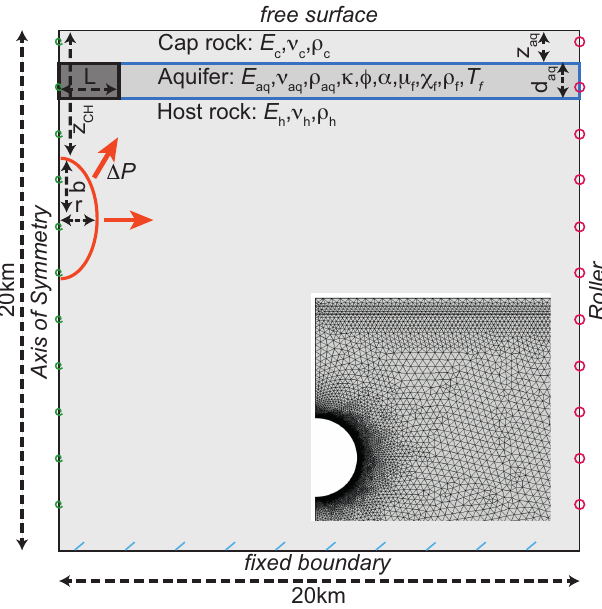
Figure 1. 2-D axisymmetric model set-up: a boundary load (cid:49)P is applied on a cavity at depth, with the radius r for the spherical case or vertical semi-axis b for the ellipsoidal case, respectively. This strains the surrounding linear elastic host rock (granitic crust), the poroelastic aquifer and the overlying linear elastic cap rock (clay). The water-saturated aquifer is modelled as either a vesicular lava flow or unconsolidated pyroclasts. An aquifer not covering the chamber but starting at some lateral distance L is realized by setting the darker grey region impermeable. The bottom boundary is fixed, the upper boundary is treated as a free surface, the lateral bound- aries have a roller condition. There is no flow outside the aquifer; stress and displacement at the internal boundaries are continuous. An extract of the finite element mesh is shown only for illustration. The mesh density is finer around the cavity, at aquifer boundaries and the free